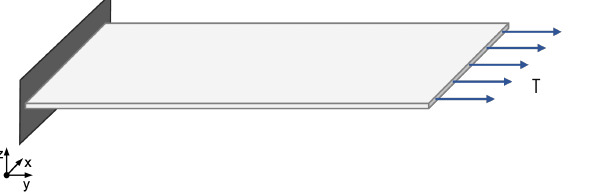
Figure 1. Structural model considered for illustrating the local model correction